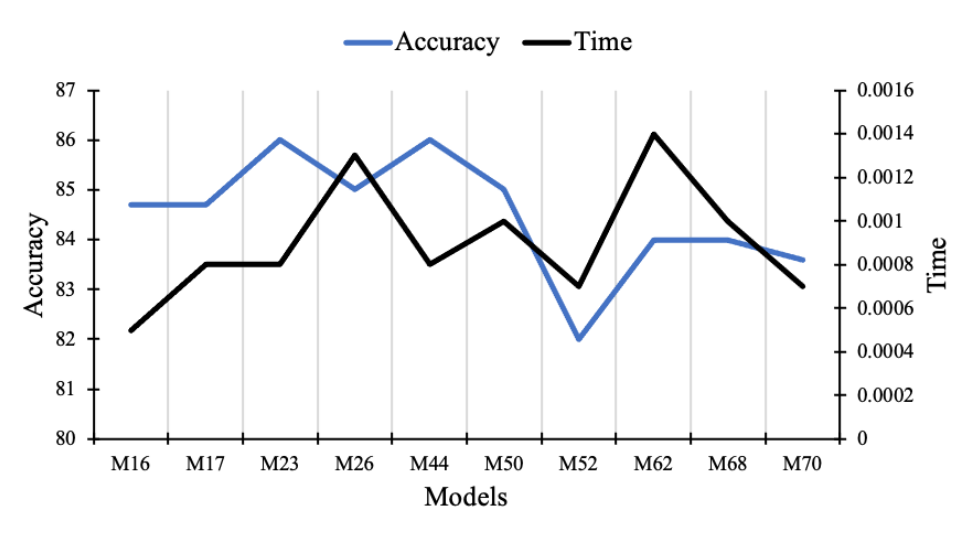
Figure 5. Line graph for top 10 models performance based on accuracy and time.